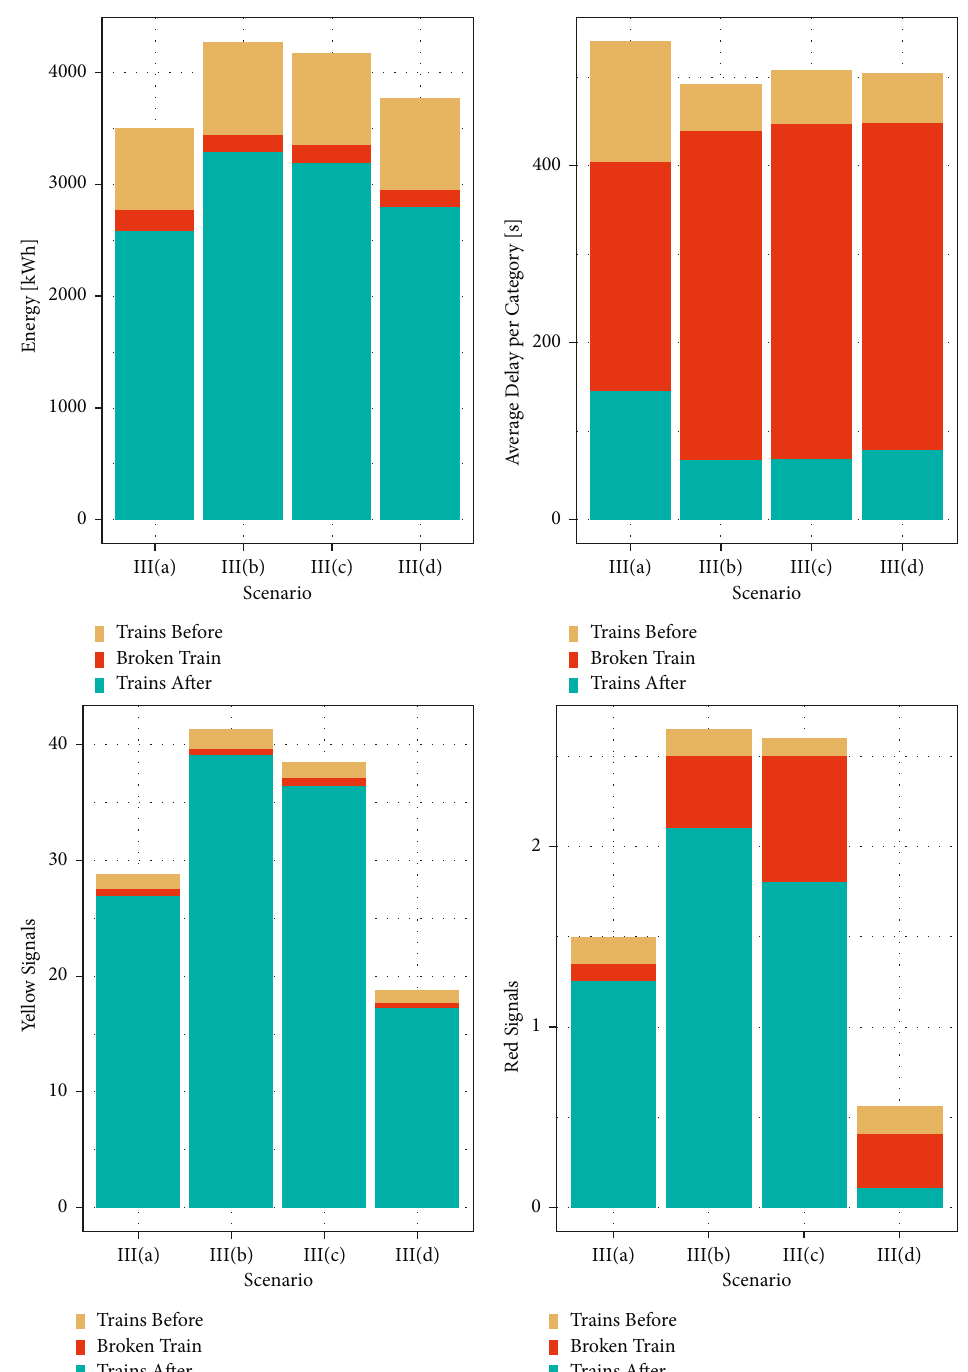
Figure 9: Analysis of Scenario III by energy/average delays (top), and yellow/red signals (bottom), for trains before or after the disrupted